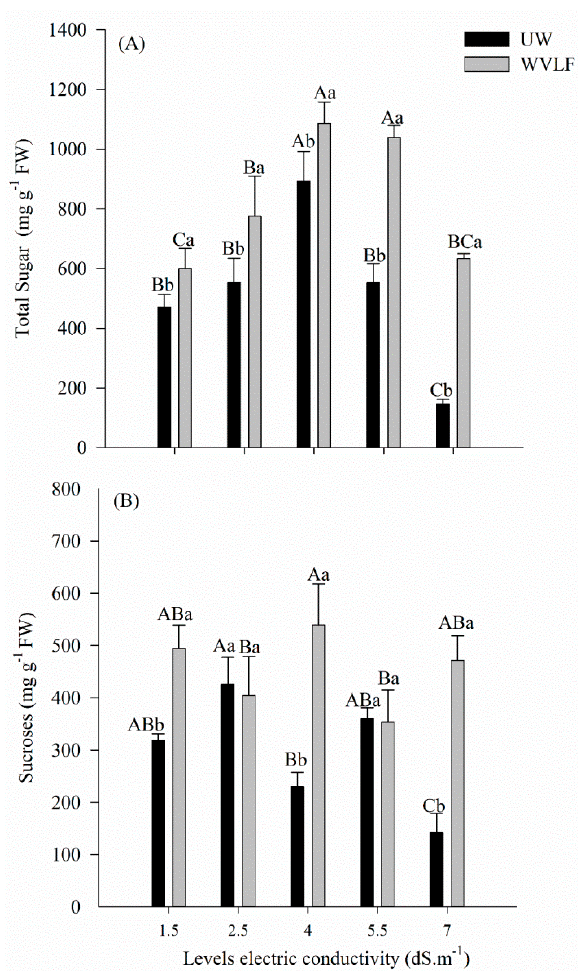
Figure 1. Total sugar ( A ) and sucrose ( B ) contents in tomato leaves for different levels of fertigation, and the handling of irrigation with electromagnetically treated (WVLF) and untreated water (UW). Means followed by the same letter (lowercase compares the type of water and uppercase compares the salinity doses) do not differ statistically ( p < 0.05) according to the Tukey test. Error bars indicate the standard deviation in the mean of four replicates ( n = 4).